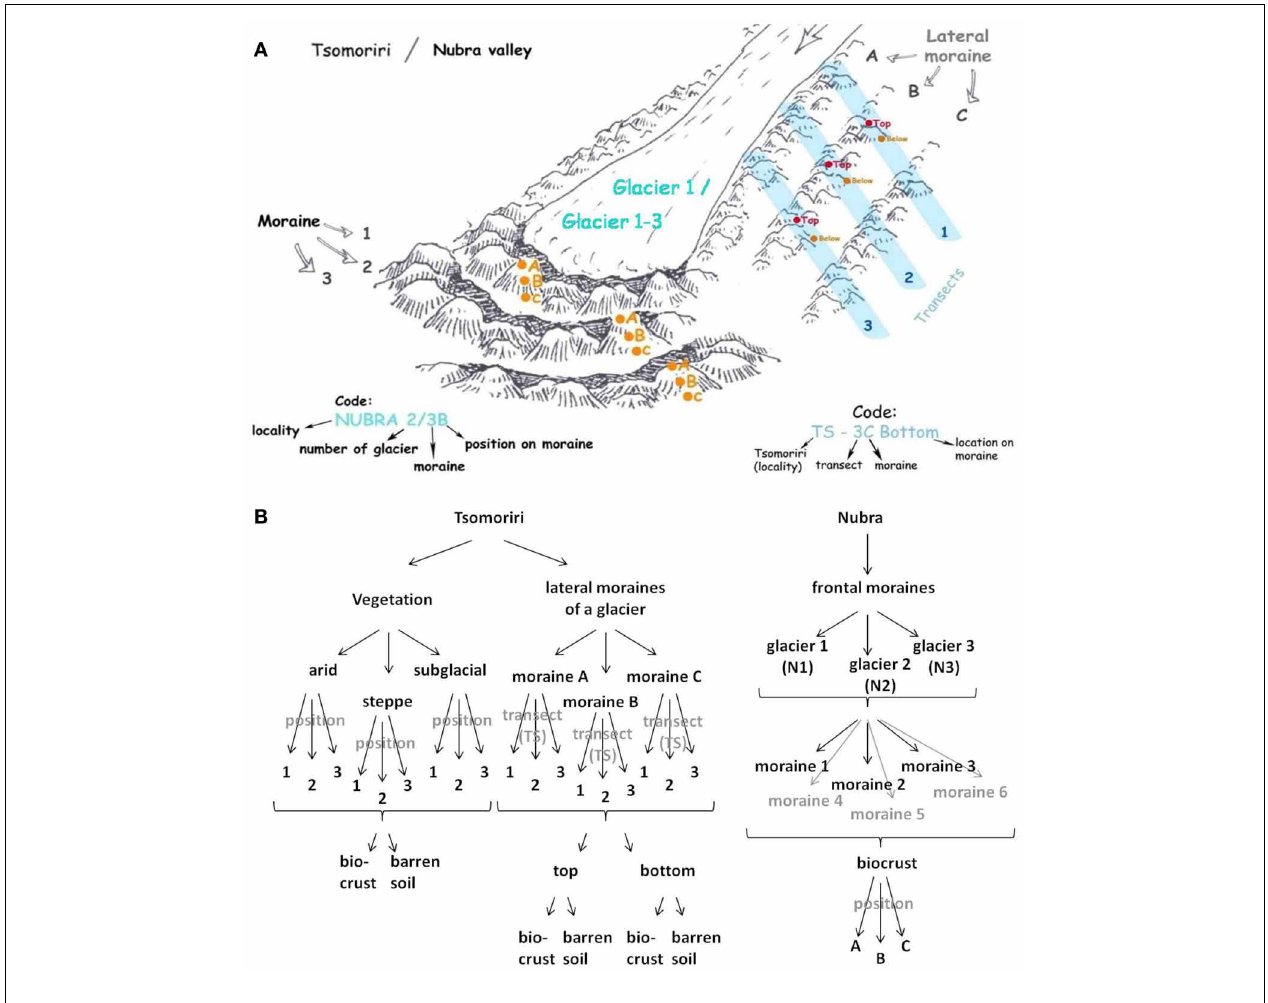
FIGURE A1 | (A) Schematic depiction ofthelocationofsamplingsites alongaglacierandcodeofsampledenotation. (B) Overviewofsoilsamples takenatdifferent positions atTsomoriri andNubra.InTsomoriri samples of